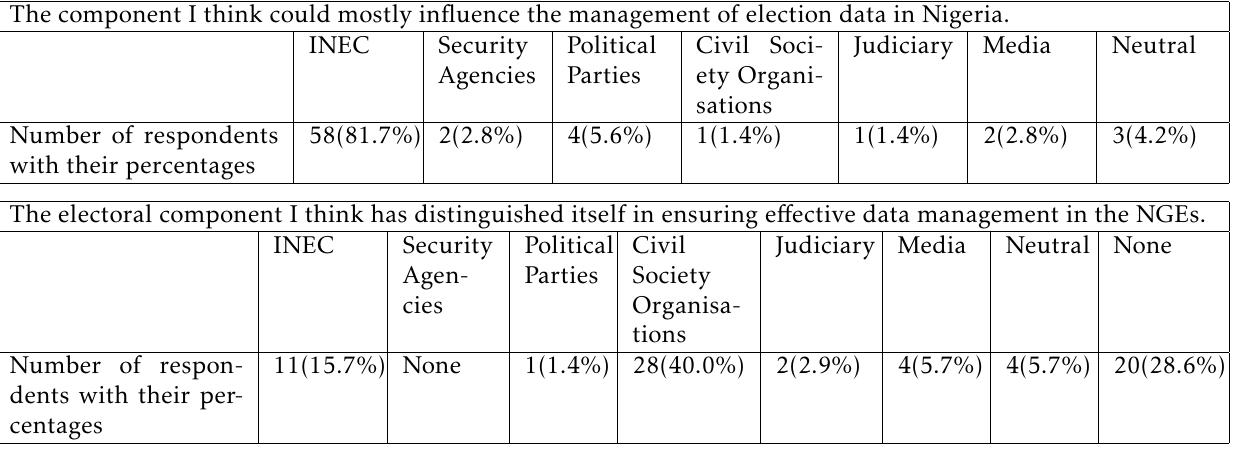
Table 2. Participants’ opinion related to components of electoral processes in the NGEs.